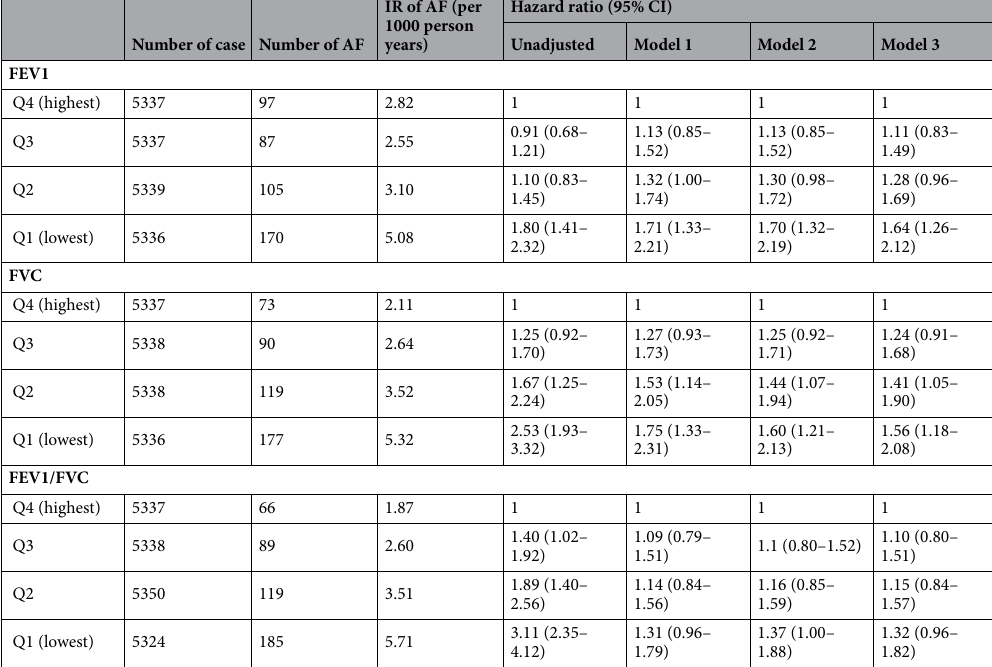
Table 3. Incidence rate and hazard ratios for the risk of atrial fibrillation according to quartiles of FEV 1 , FVC, and FEV 1 /FVC ratio. Model 1: Adjust by age, sex. Model 2: Adjust by age, sex, body mass index, household income, education, alcohol consumption, smoking, diabetes mellitus, hypertension, dyslipidemia. Model 3: Adjust by age, sex, body mass index, household income, education, alcohol consumption, smoking, diabetes mellitus, hypertension, dyslipidemia, white blood cell, estimated glomerular filtration rate, prior stroke, prior ischemic heart disease, asthma. FEV 1 , forced expiratory volume in 1 s; FVC, forced vital capacity; AF, atrial fibrillation; IR, incidence rate (events/1000 person years); CI, confidence interval.